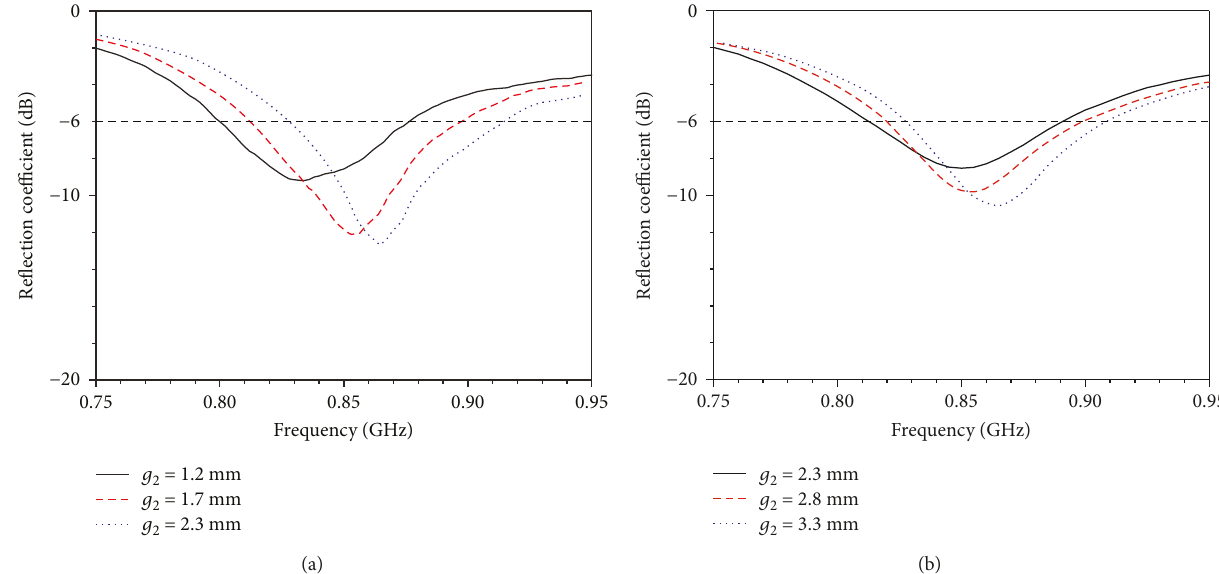
Figure 11: Measured re fl ection coe ffi cients of the (a) conventional and (b) optimized antennas according to variation of the g